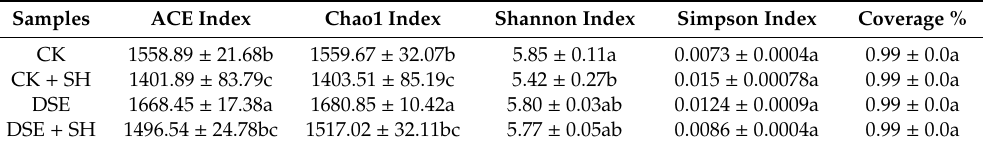
Figure 4. One-way ANOVA bar plot showing the significant differences in bacterial genera in CK, CK + SH, DSE, DSE + SH treatments. CK: cottonseed shell blank culture medium inoculation. DSE: P. bamuru A024 inoculation alone. CK + SH: Single inoculation with R. solani SH01. DSE + SH: sequential inoculation with P. bamuru A024 and R. solani SH01. * p < 0.05 (both sides). Table 7. DSE inoculation impacts on soil bacterial community diversity under CK, CK + SH, DSE, DSE + SH